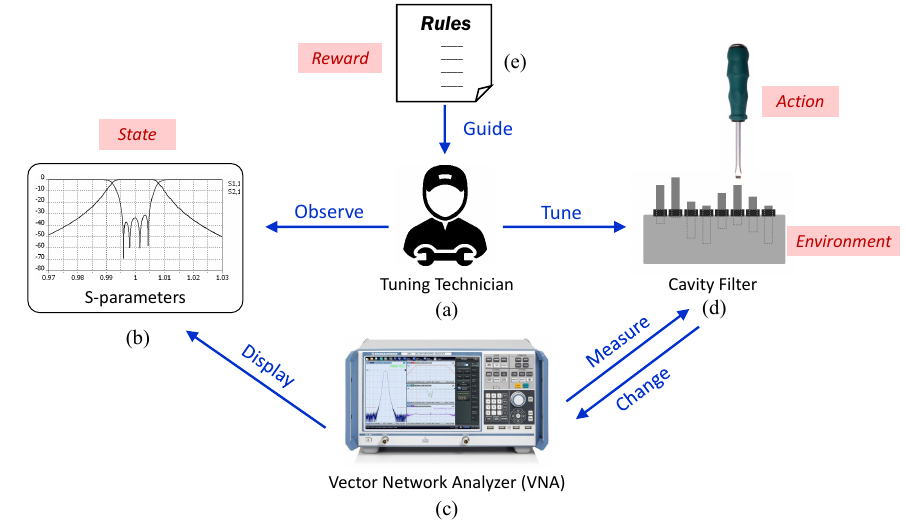
Figure 2. The process of manually tuning a cavity filter. The tuning technician ( a ) observes the S–parameters curve ( S 11 ) ( b ) as shown in a Vector Network Analyzer ( c ) and adjusts the screws inserted into the cavity filter with a screwdriver ( d ) based on his own experience and tuning strategies ( e ). The whole process is very much similar to a reinforcement learning